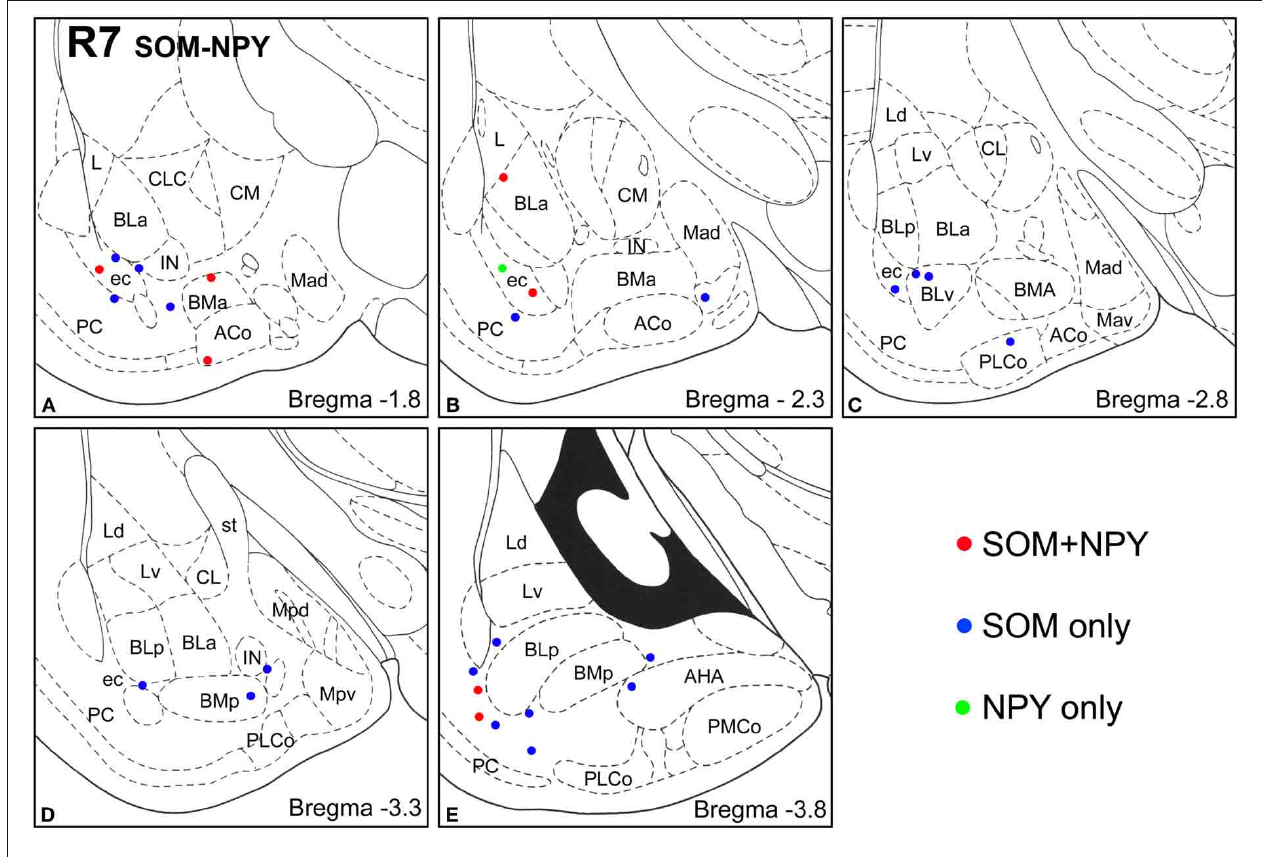
FIGURE 4 | Sections arranged from rostral (A) to caudal (E) depicting the locations of long-range non-pyramidal neurons in the amygdalar region expressing SOM and/or NPY in case R7. Each dot represents one neuron. Red dots are FG +